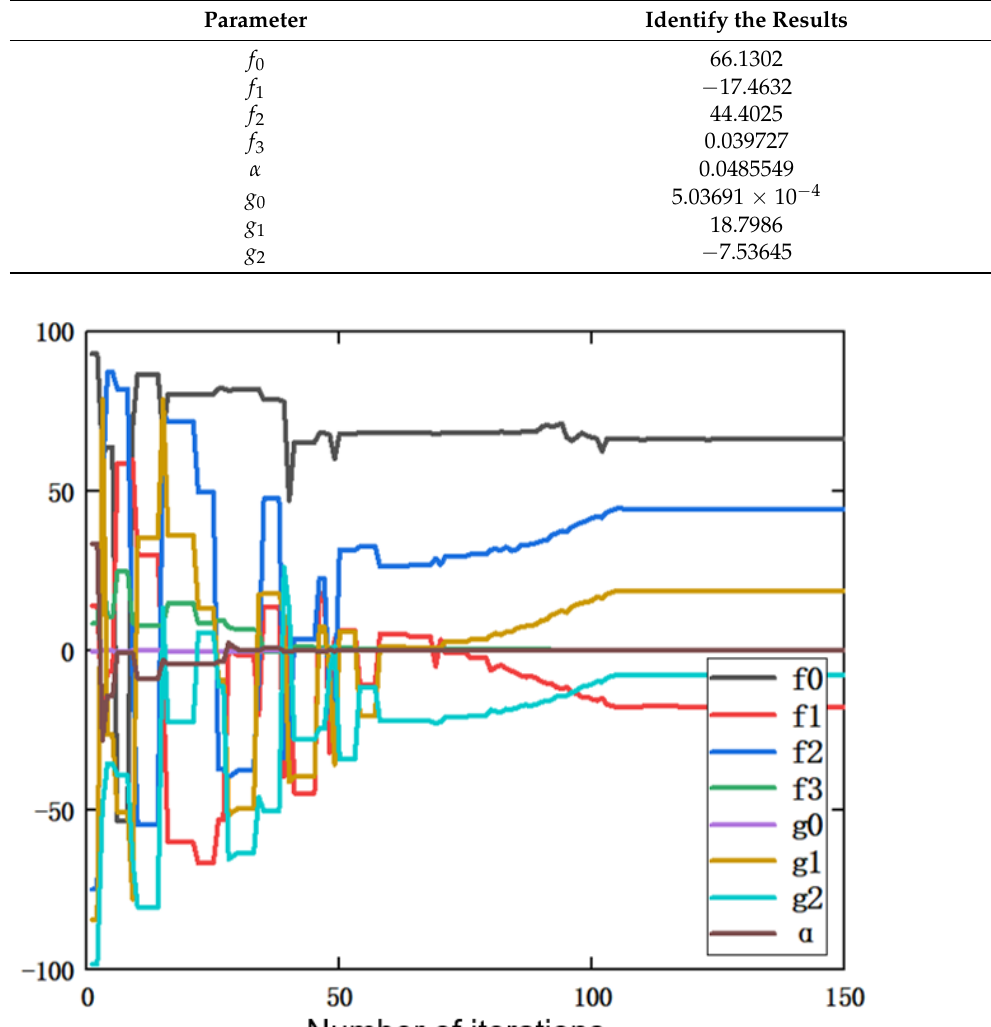
Table 1. Improved artificial fish swarm algorithm whole segment identification model parameters.